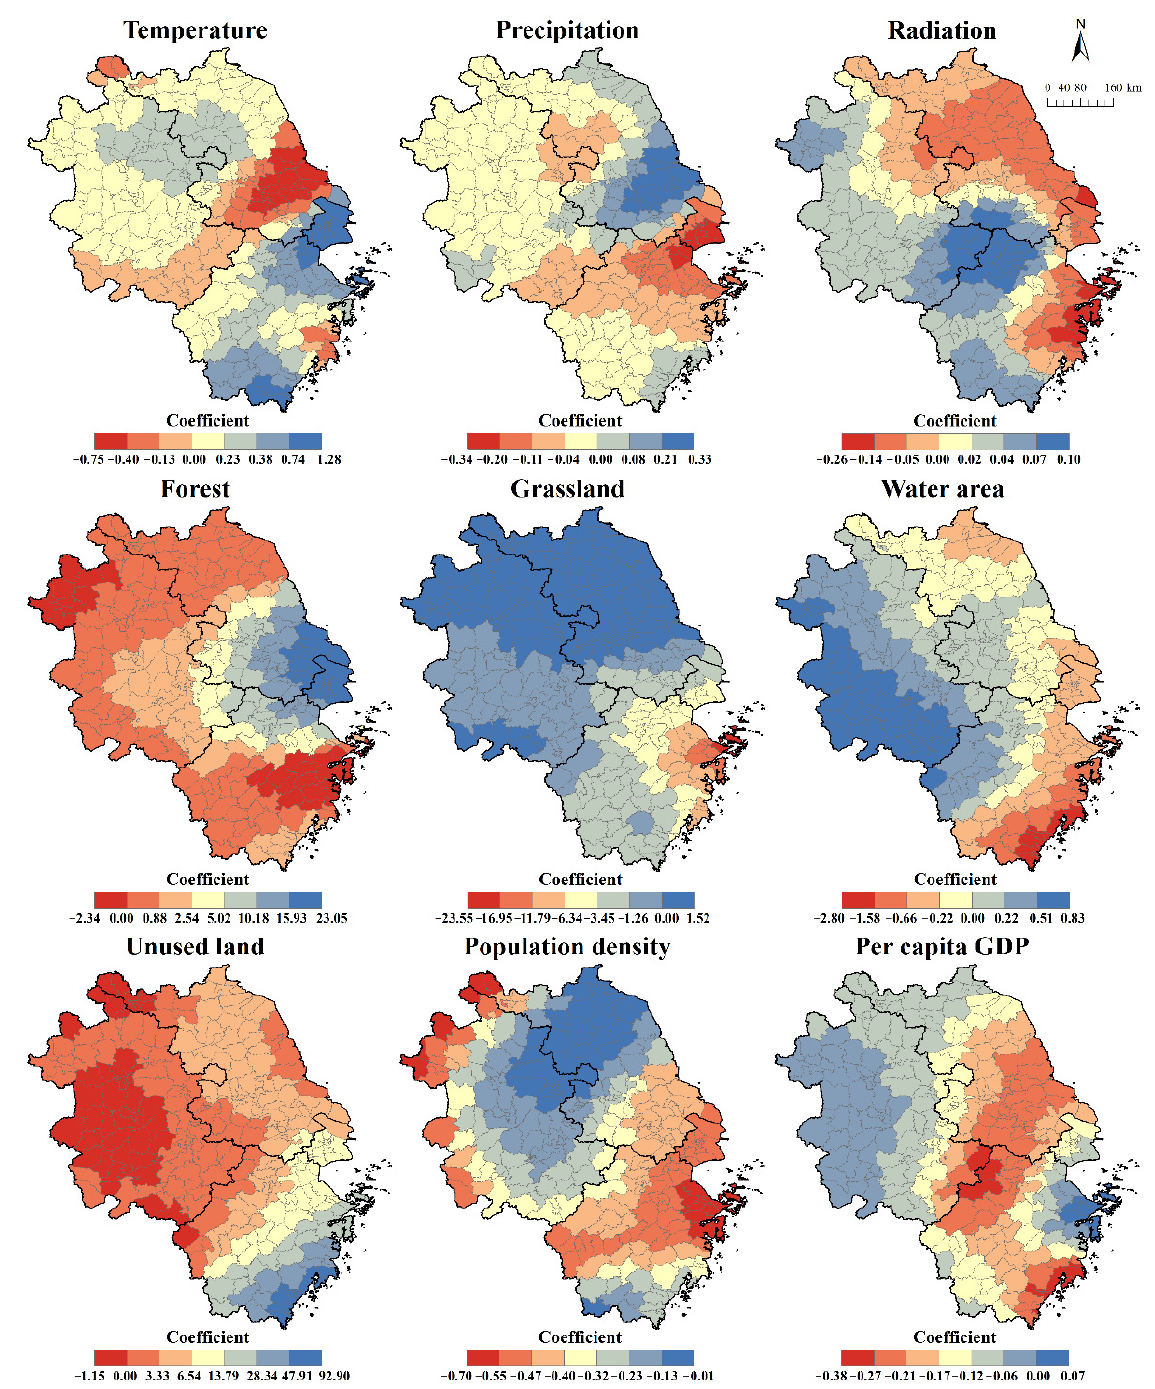
Figure 7. Spatial distribution of the GWR coefficients between carbon budget changes and each driver in the YRD region. A positive coefficient indicates a positive correlation between the driver and the carbon budget changes, and a negative coefficient indicates a negative correlation.